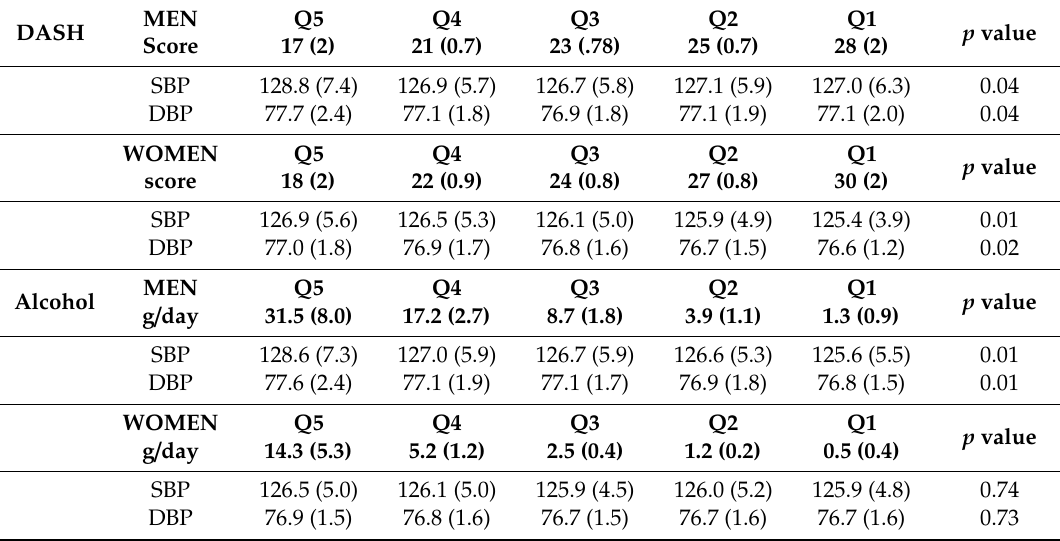
Figure 2. Blood pressure and DASH score quintiles and alcohol consumption in men from the Esteban survey 2014–2016. Q1: better quintile of DASH scores and alcohol consumption (lowest consumption). Table 4. Adjusted BP according to quintiles of DASH scores and alcohol consumption in men and women. Q5: worst quintile of DASH scores and alcohol consumption (high) Q1: best quintile of DASH scores and alcohol consumption